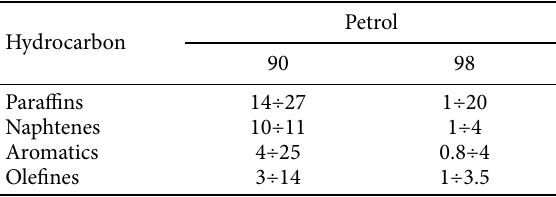
Table 1. The percentage content of various hydrocarbons in petrol